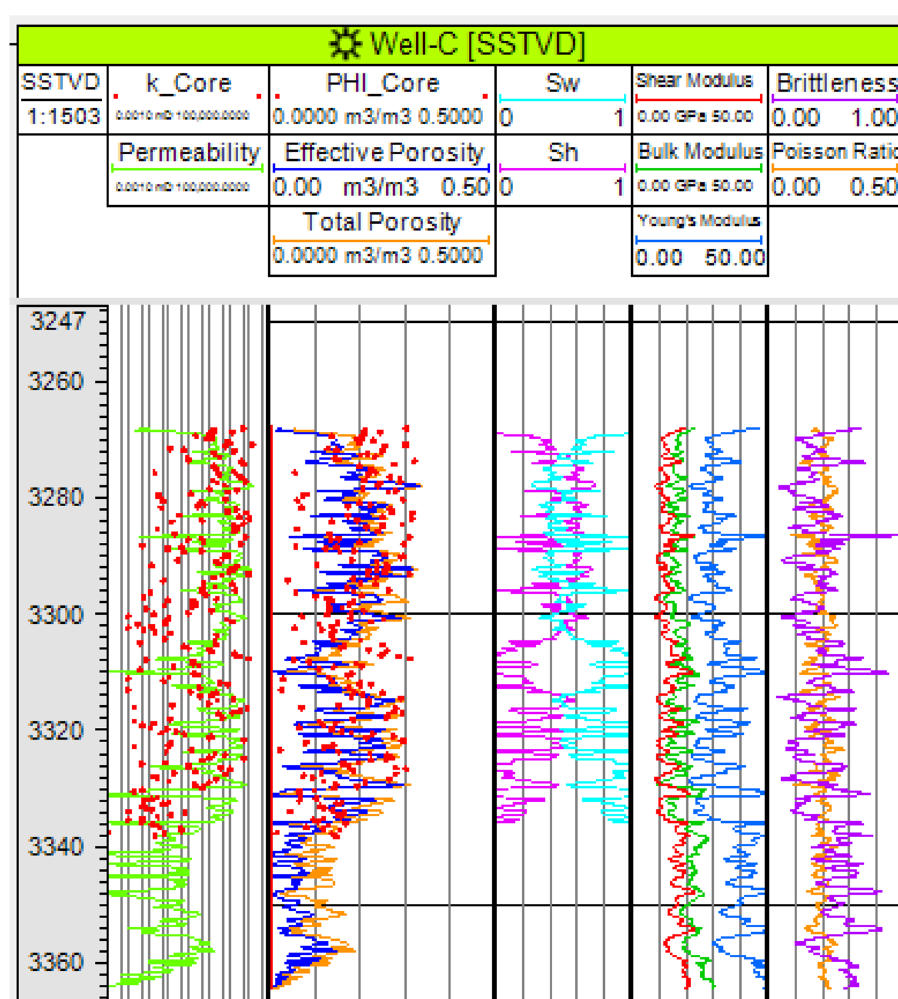
Fig. 14 Petrophysical and geomechanical properties in